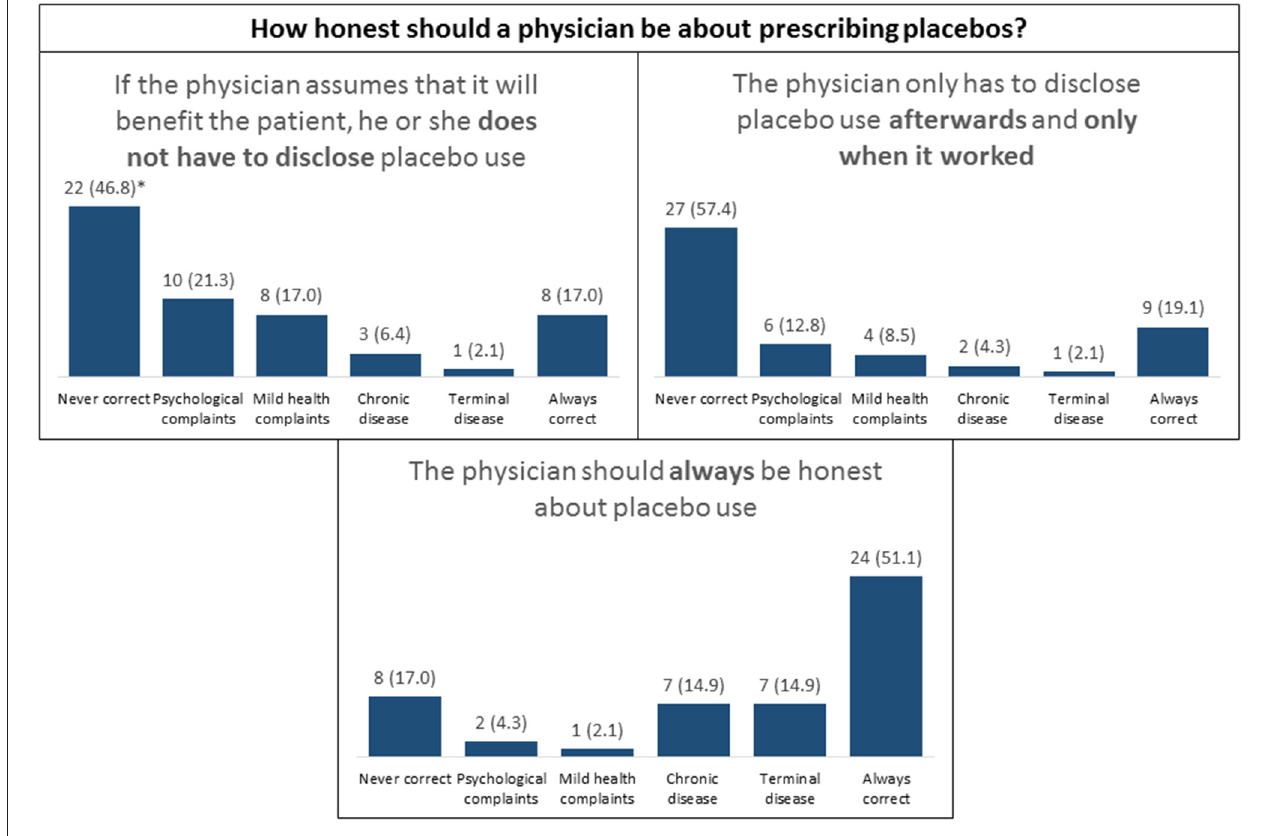
FIGURE 3 | Outcomes of placebo transparency scores in different scenarios. * N